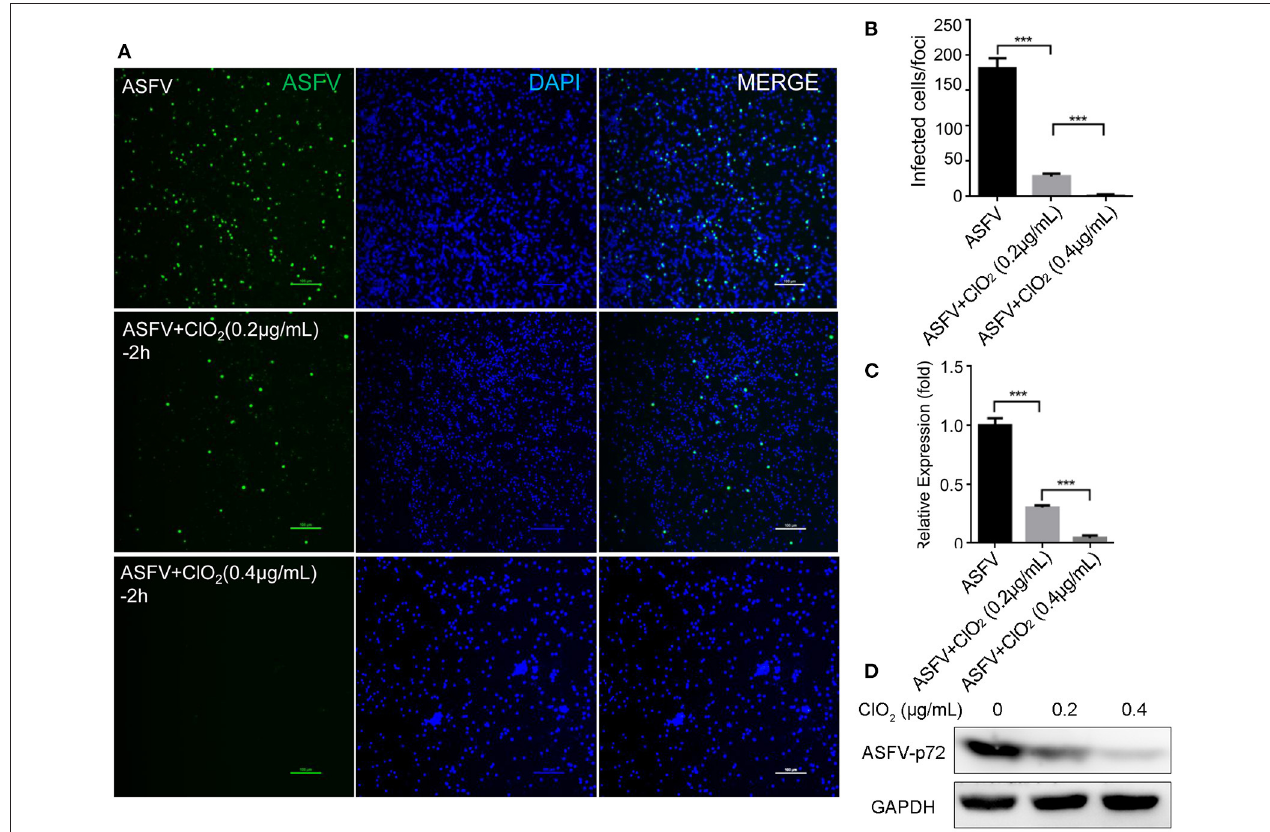
FIGURE 5 | ClO 2 inactivates ASFV virions in a dose-dependent manner. (A,C,D) ASFV was pre-incubated with various concentrations of ClO 2 for 2h at 37 ◦ C. The mixtures were then added to PAMs. After incubation for 2h at 37 ◦ C, cells were supplied with fresh RPMI-1640 medium containing 2% FBS and cultured for another 24h at 37 ◦ C. Cells were finally harvested for the analysis of IFA (A) , qRT-PCR (C) and western blot (D) . Bar, 100 µ m. (B) Average number of infected cells per foci. Data are representative of the results of three independent experiments (means ± SE). Significant differences compared with control group are denoted by *** P <